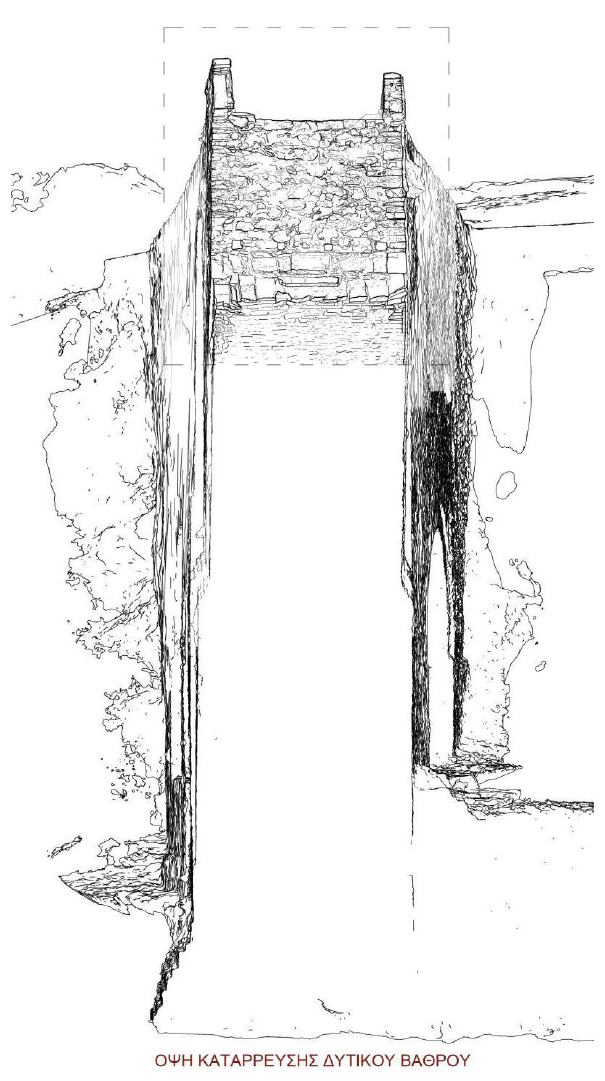
Figure 13. Façade of the West Pillar ruins. 2D elevation plan created form the 3D model, enhanced with CAD drawn details